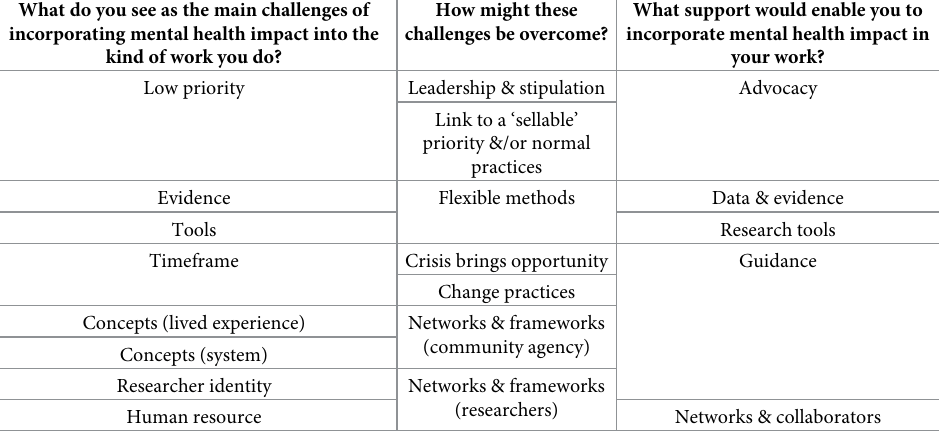
Table 3. Overview of the results. What do you see as the main challenges of incorporating mental health impact into